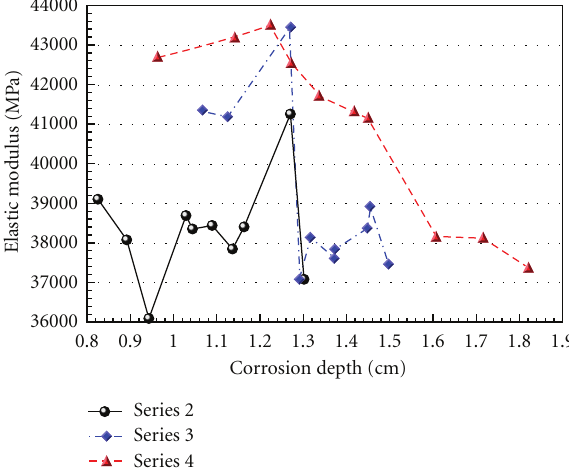
Figure 9: Relation between corrosion depth and mass loss.